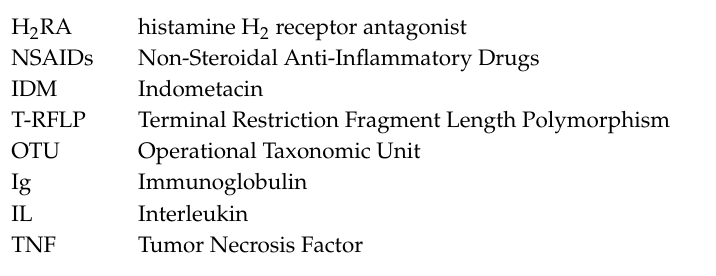
Figure S1: Pharmacological interference experiments of IDM and H 2 RA on intestinal epithelial